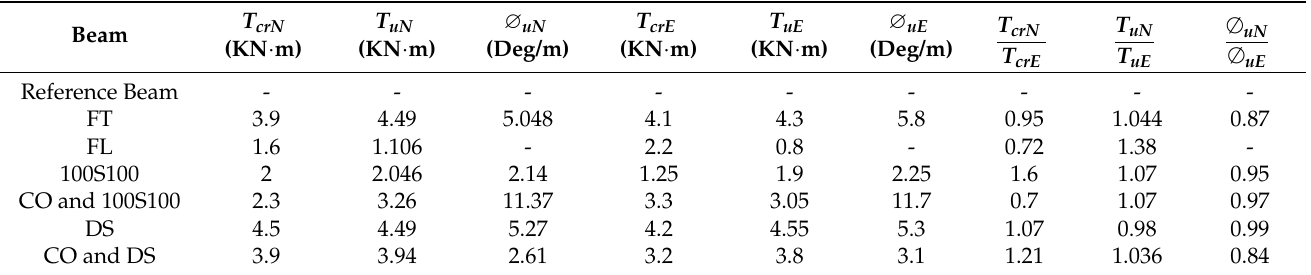
Table 6. Comparison of the numerical and experimental values of the cracking torque, ultimate torque, and ultimate angle of the twist, GFRP.